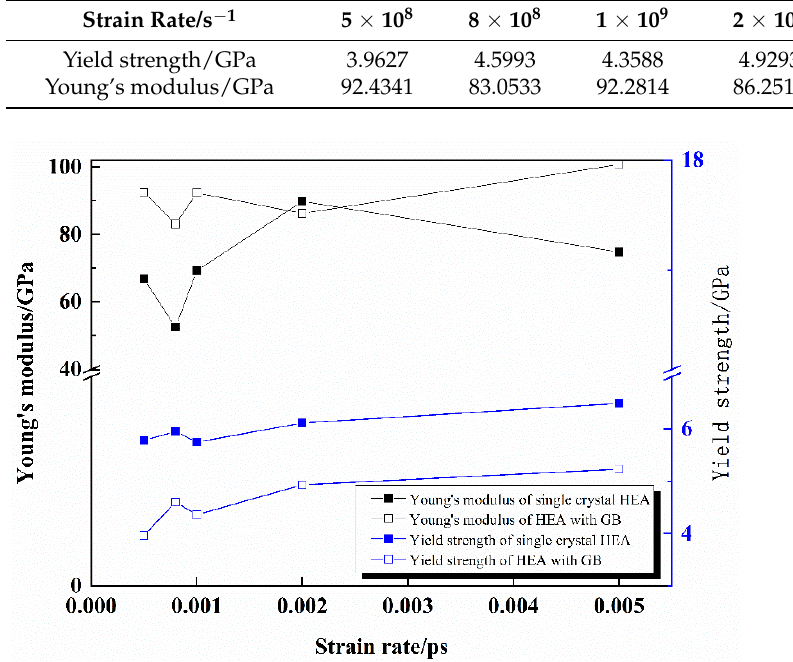
Figure 6. Comparison of Young’s modulus and yield strength between single crystal Al 0.1 CoCrFeNi HEA and Al 0.1 CoCrFeNi HEA with grain boundary. Table 2. Young’s modulus and yield strength of GB -HEA at different strain rates.